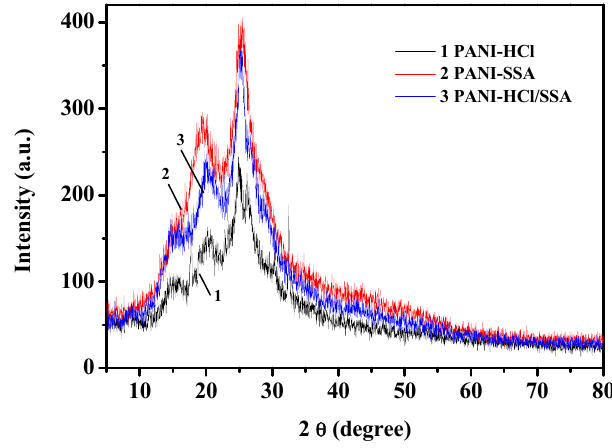
Figure 3. XRD pattern of different types of acid-deposited PANI.